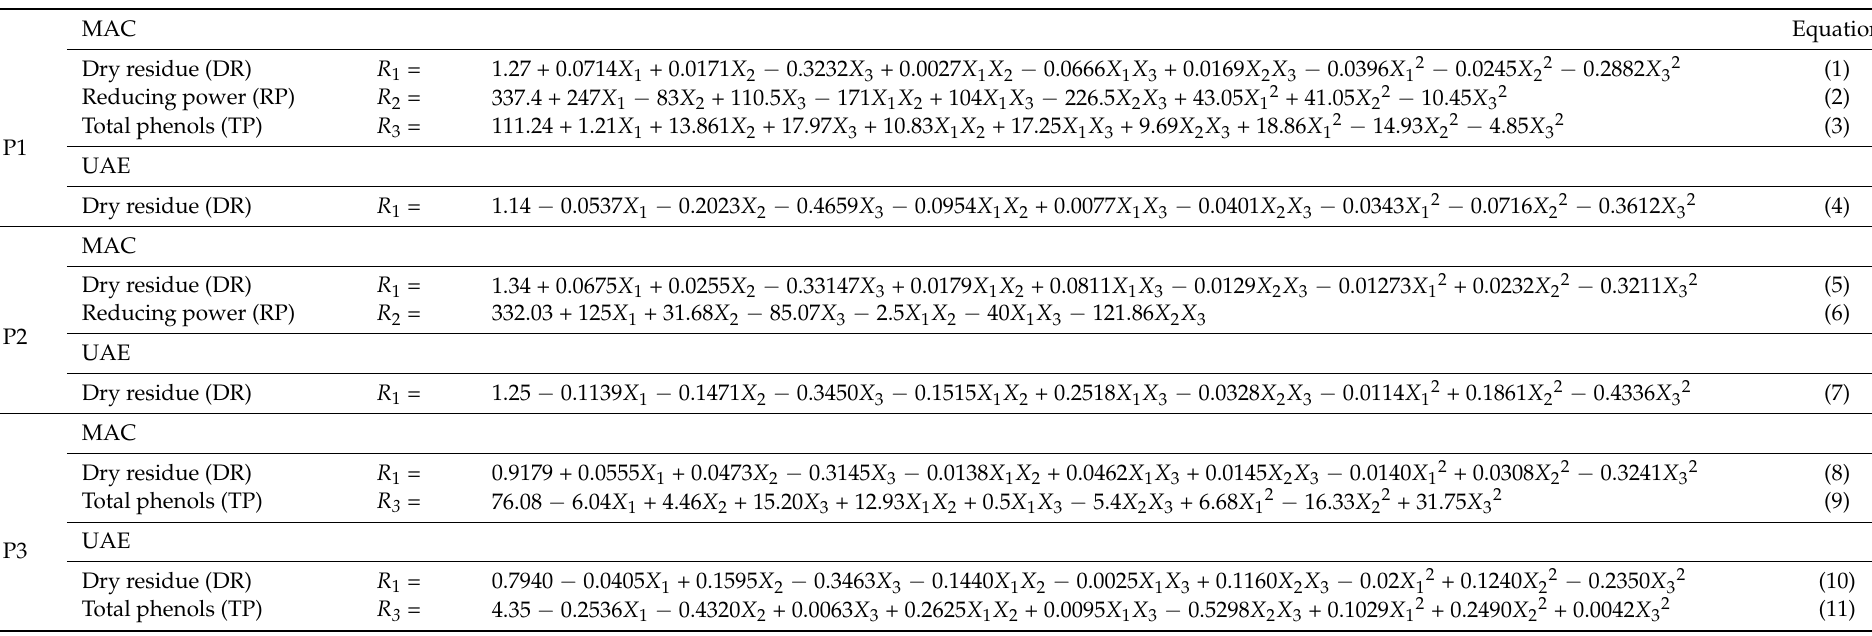
Table 3. Mathematical models derived from the second-order polynomial model with interaction described in Equation (12) in terms of encoded values for the two extraction techniques (heat-assisted extraction: HAE; and ultrasound-assisted extraction: UAE) and the three responses, when available ( R 1 or DR; R 2 or RP; and R 3 or